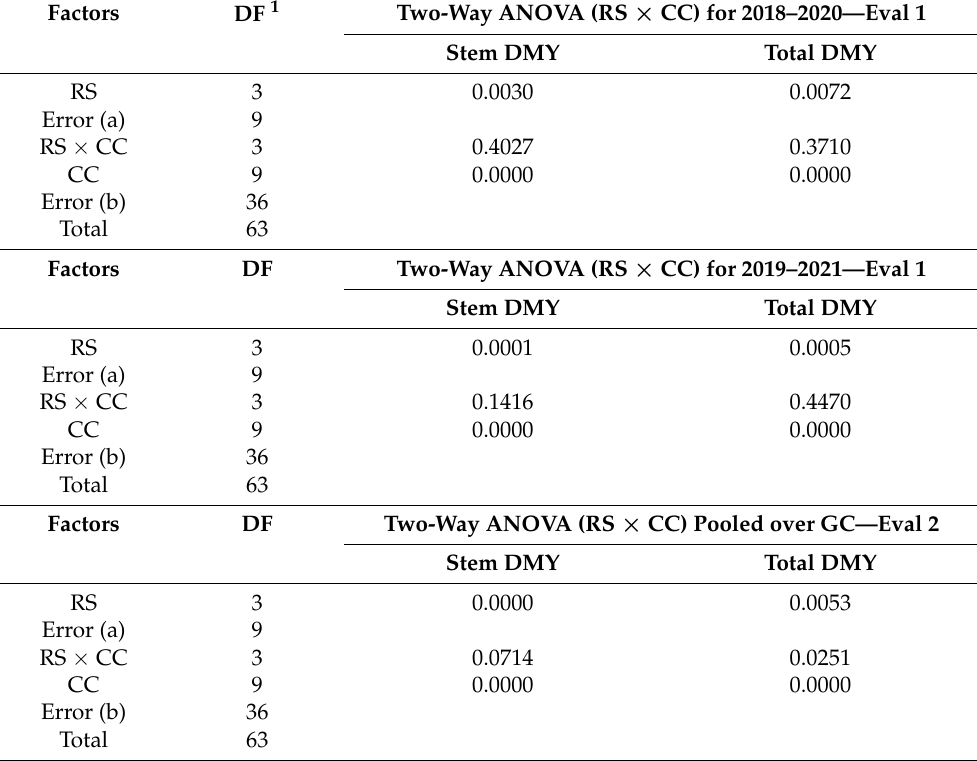
Table 8. The effects of sulla row spacing and cover crops on sulla cumulative two-year stem DMY and total DMY in the 2018–2020 and 2019–2021 growing cycles. Data of Eval 1 were analyzed separately for each growing cycle. Data of Eval 2 were pooled over growing